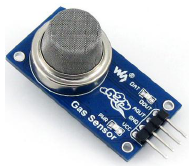
Figure 4. Smoke sensor MQ-2 module physical map.